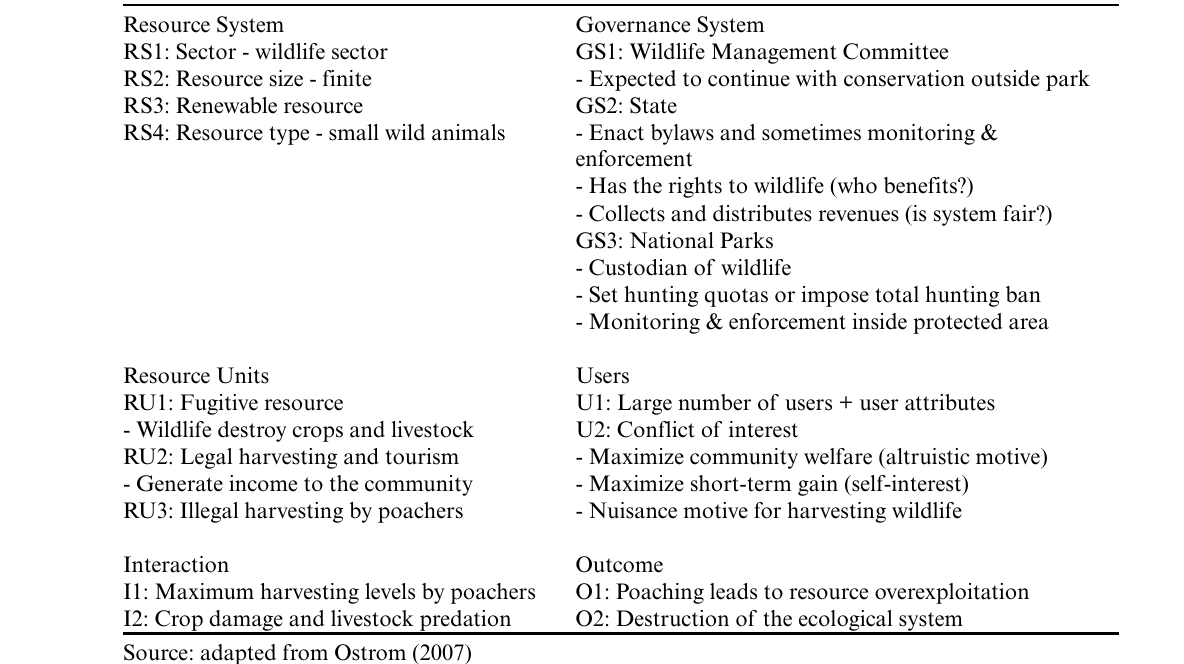
Table 1 . Second tier variables